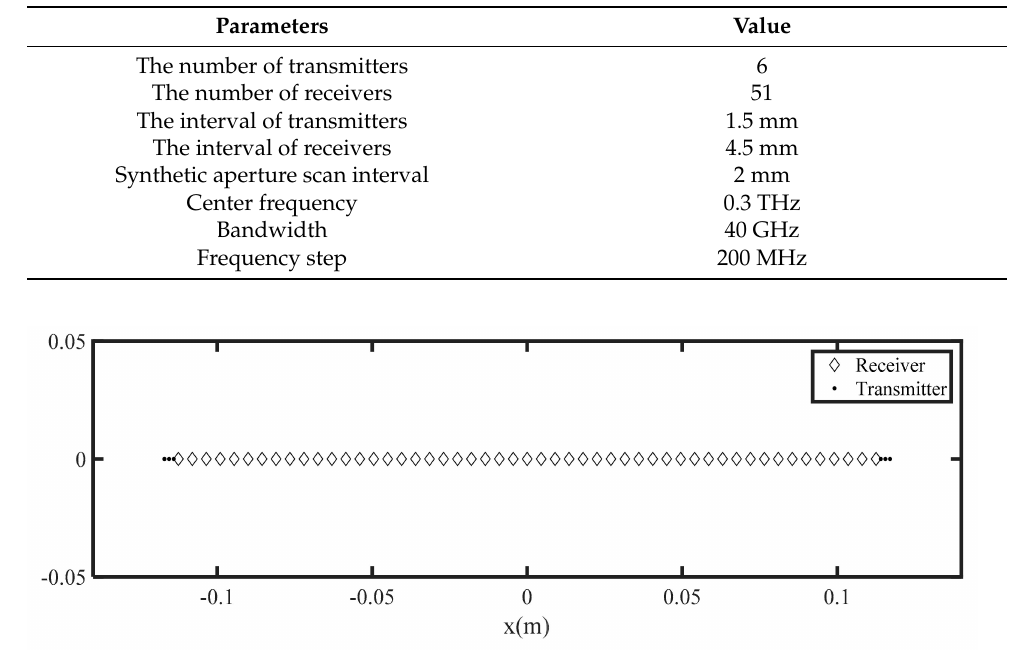
Figure 6. The MIMO array applied in the simulation. The 3-D imaging results and 2-D projection on the x-y plane results under the 35 dB dynamic are given in Figure 7; it is obvious that the imaging results of the BPA and PSM algorithms are both well-focused but disturbed by the high-energy sidelobes, resulting in blurring of the main lobe. Then, Figure 8 shows the CF-BPA and the proposed MCF-PSM imaging results. The 1-D profiles comparison of the center point along the x-axis are shown in Figure 9. From Figures 8 and 9, it can be found that both the CF-BPA and MCF-PSM algorithms can suppress the sidelobes and get a sharper main